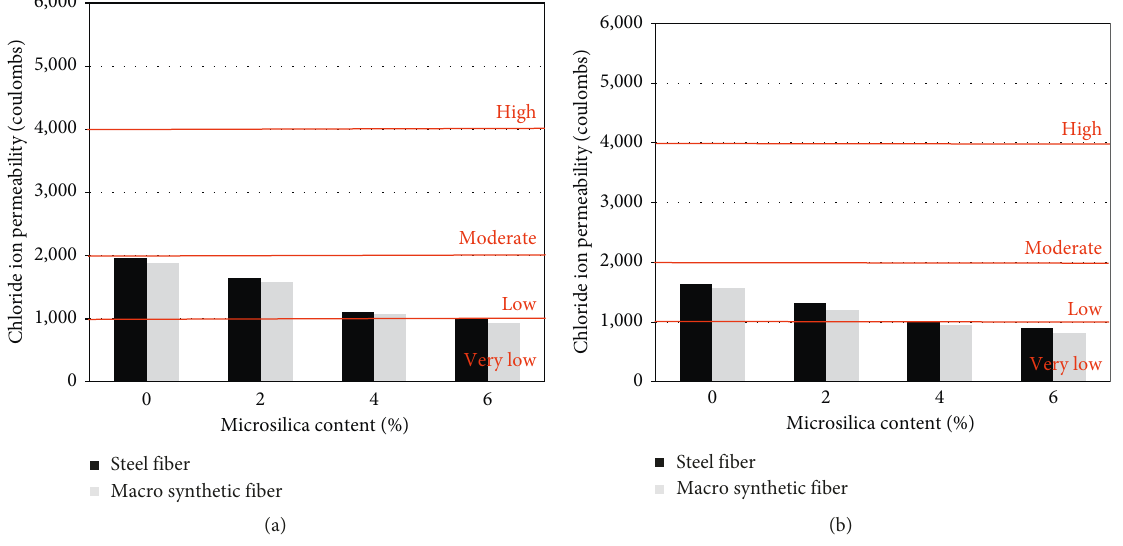
Figure 4: Chloride ion penetration by microsilica content: (a) 40MPa and (b)